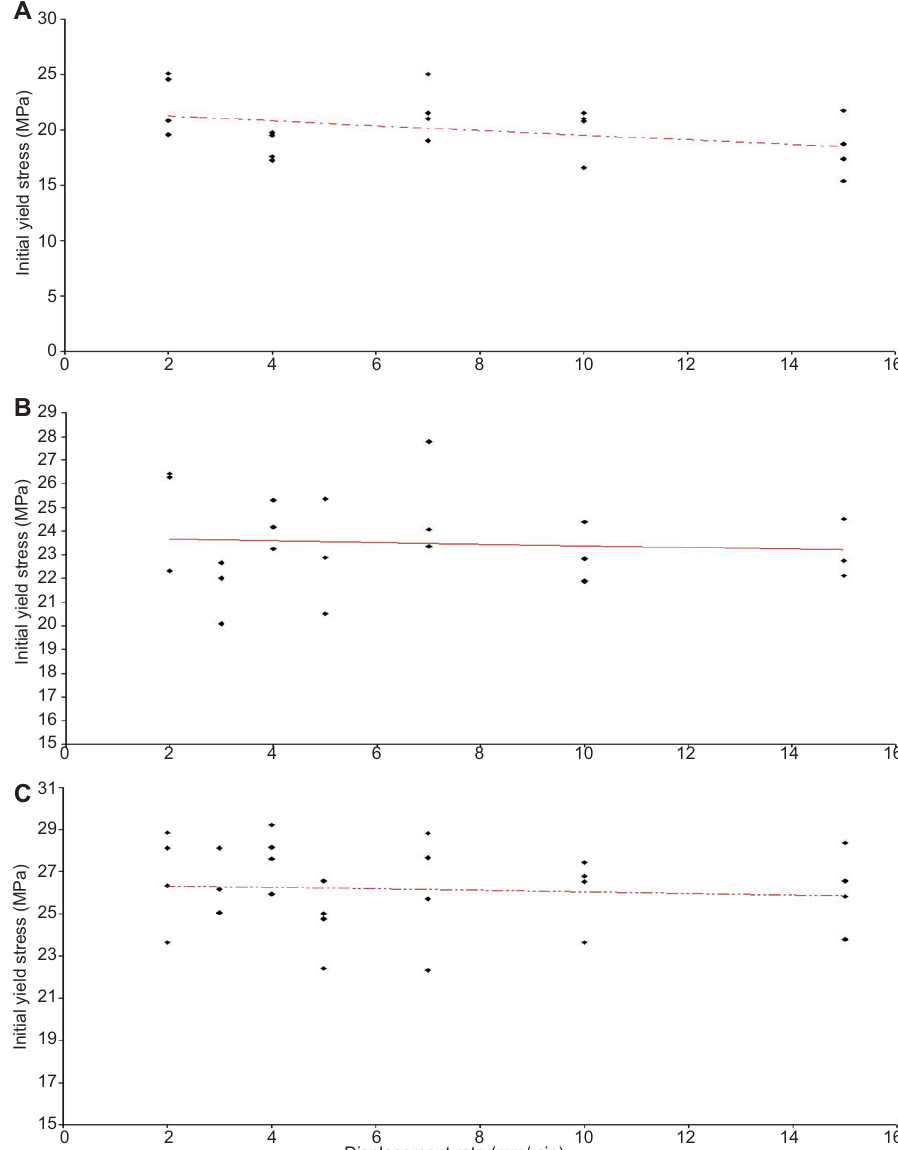
Figure 8 Effect of displacement rate on initial yield stress for (A) 1 mm, (B) 2 mm and (C) 3 mm diameter NiTi shape memory alloy wire.